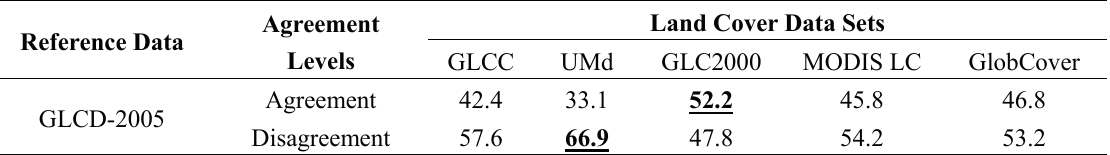
Table 5. Percent agreement (%) of the five land cover data sets and the reference data across China. Maximum percent agreement and disagreement are displayed in bold text and